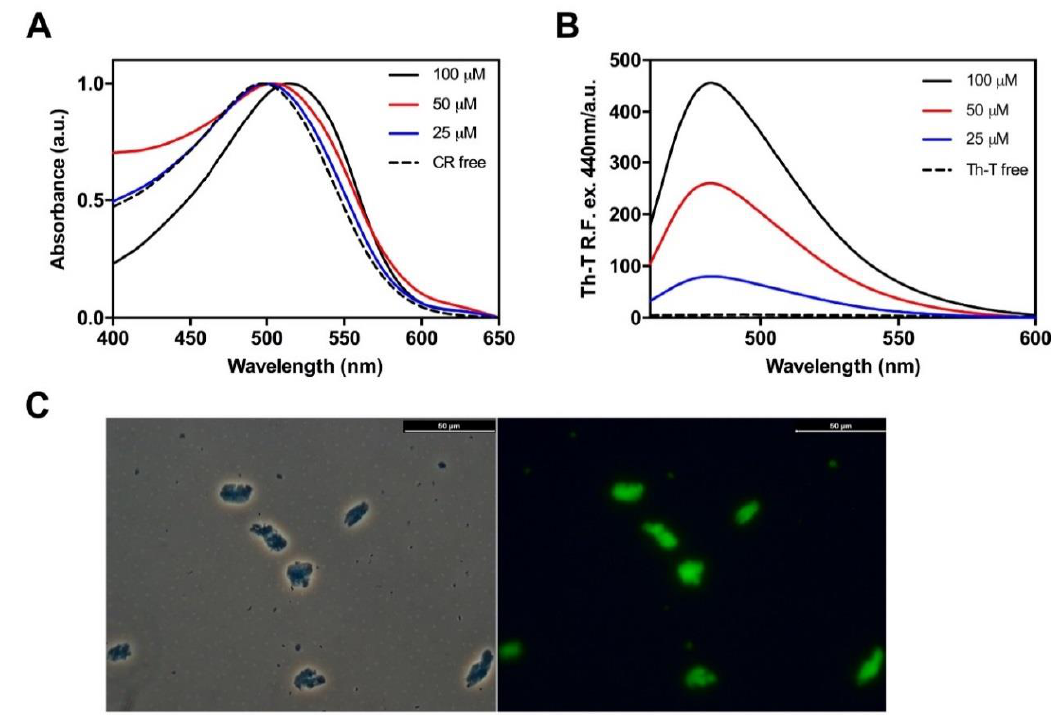
Figure 4. Binding of amyloid dyes to the cryptic amyloid core of Hsf1. ( A ) Congo red (CR) spectral changes in the presence of Hsf1 peptide incubated at various concentrations during 120 h at 25 °C; note the characteristic shift from 497 nm to 515 nm when the dye is bound to amyloid-like aggregates; ( B ) changes in the fluorescence emission spectrum of Thioflavin-T (Th-T) when excited at 440 nm upon binding to the aggregated peptide at various concentrations after 120 h incubation at 25 °C; ( C ) Thioflavin-S fluorescence of stained aggregated amyloid material of Hsf1 at 100 μM in Phosphate buffered saline (PBS) buffer after 120 h incubation at 25 °C. Images were obtained at 40× magnification by phase contrast and fluorescence microscopy displaying the green fluorescence characteristic of amyloid structures.